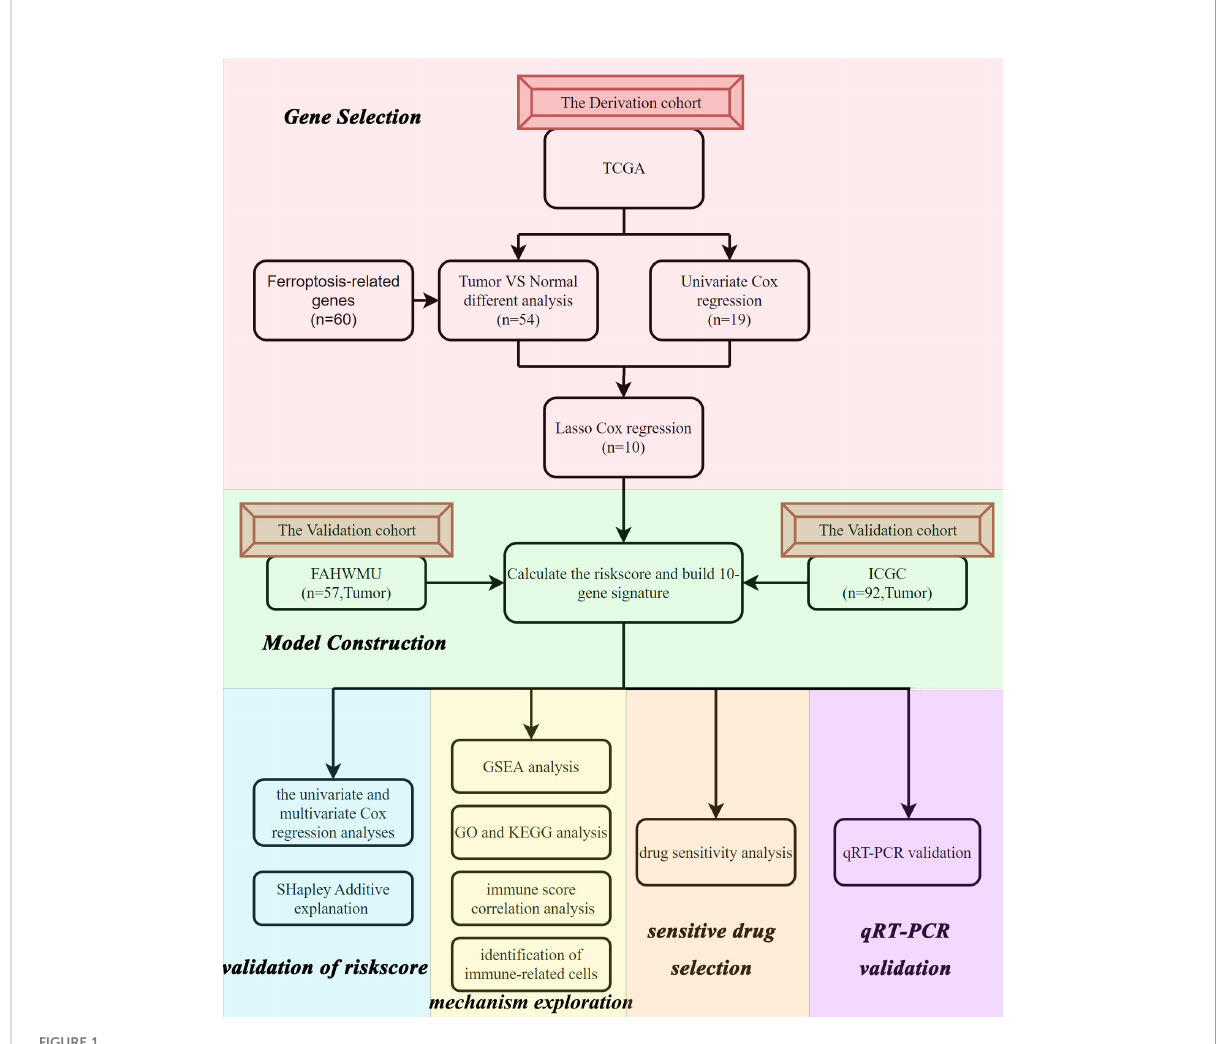
FIGURE 1 Flow chart of the data collection and